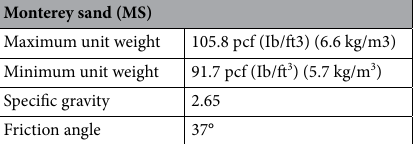
Table 1. Minimum unit weights, specific gravity, friction angle, and standard proctor values for Monterey